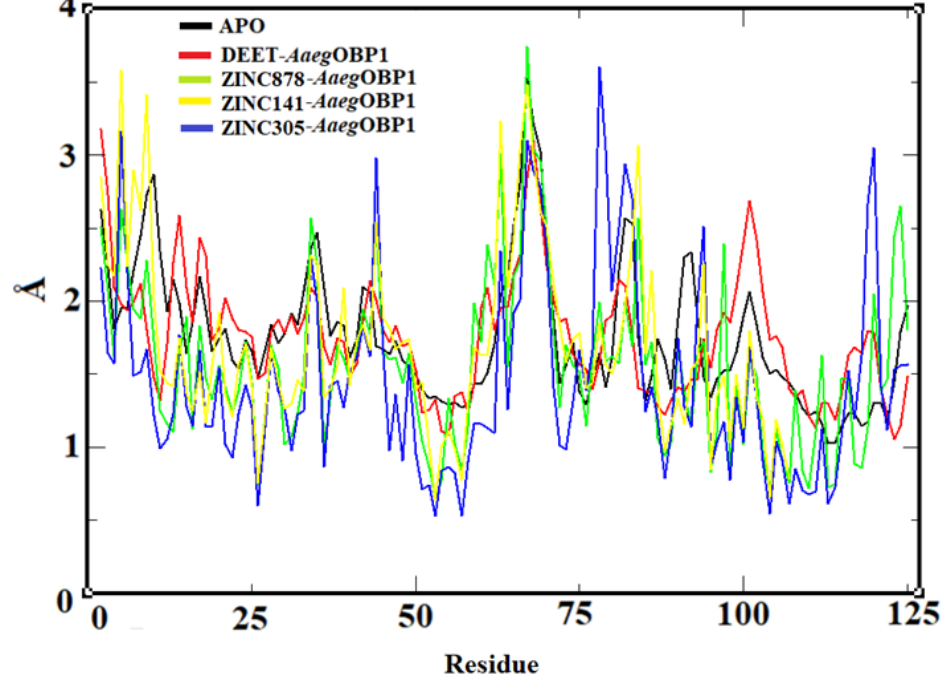
Figure 10. RMSF plot of the backbone in Aaeg OBP1 APO (black lines) and DEET/ Aaeg OBP1 (red lines), ZINC878/ Aaeg OBP1 (green lines), ZINC141/ Aaeg OBP1 (yellow lines) and ZINC305/ Aaeg OBP1 (blue lines) complexes generated by the xmgrace program.